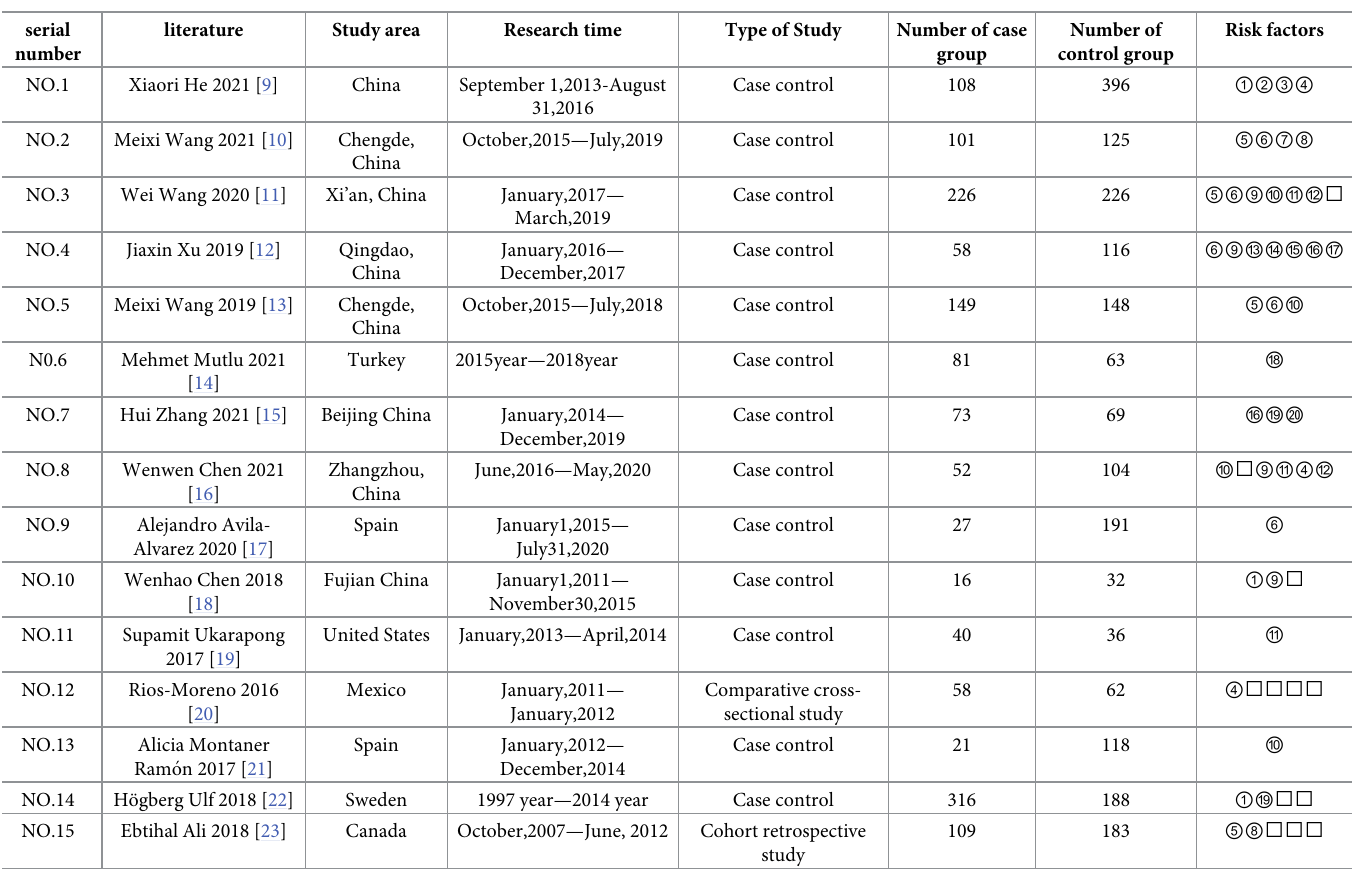
Table 1. Basic information of included